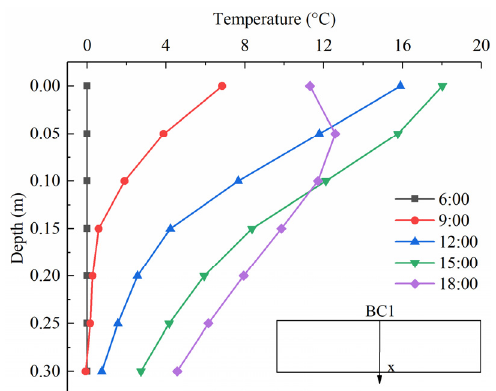
Figure 19. Temperature distributions of component T BC1 at different times.